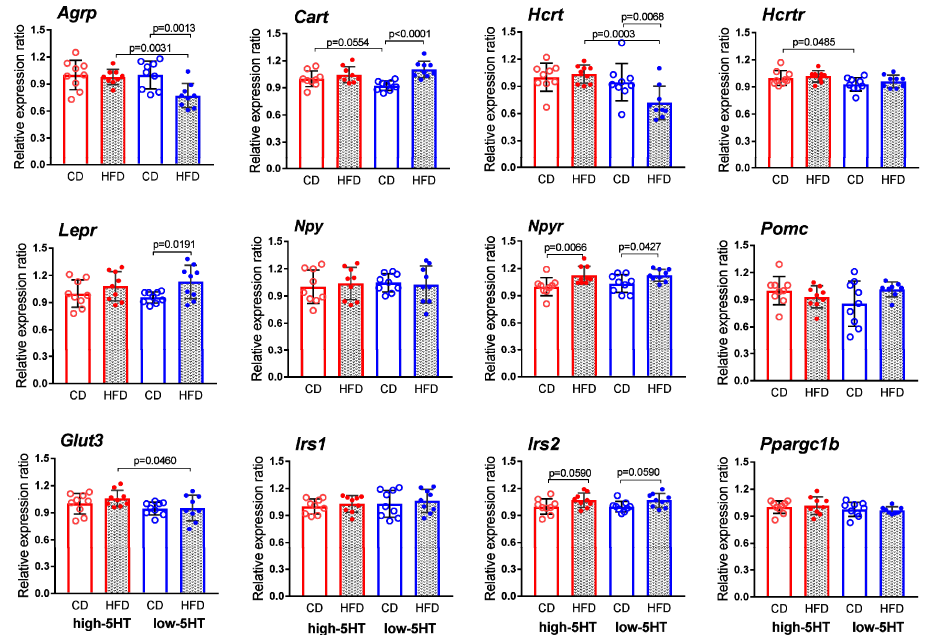
Figure 8. Hypothalamic mRNA expression levels of weight-related molecules, in animals from high-5HT and low-5HT sublines after 11 weeks on control diet (CD) or high-fat diet (HFD). Expression levels were normalized to the mean of two reference genes ( Actb and Gapdh ) and are shown as a relative expression ratio between groups, with high-5HT animals receiving the control diet set at 1.00. Data are presented as means ± SD; N = 9 per group; p -values obtained by LSD or Dunn’s post-hoc test after one-way ANOVA or Kruskal Wallis test, as appropriate, are indicated. Abbreviations: Agrp = agouti-related peptide; Cart = cocaine-and amphetamine-related transcript; Glut3 = glucose transporter 3; Hcrt = hypocretin; Hcrtr1 = hypocretin receptor1; Irs1(2 ) = insulin receptor substrate 1(2); Lepr = leptin receptor; Npy = neuropeptide Y; Npyr = neuropeptide Y re- ceptor; Pomc = pro-opiomelanocortin; Ppargc1b = peroxisome proliferator-activated receptor gamma coactivator 1